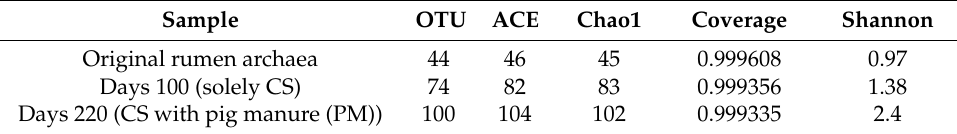
Table 1. Richness and diversity indexes of archaeal communities under different conditions.